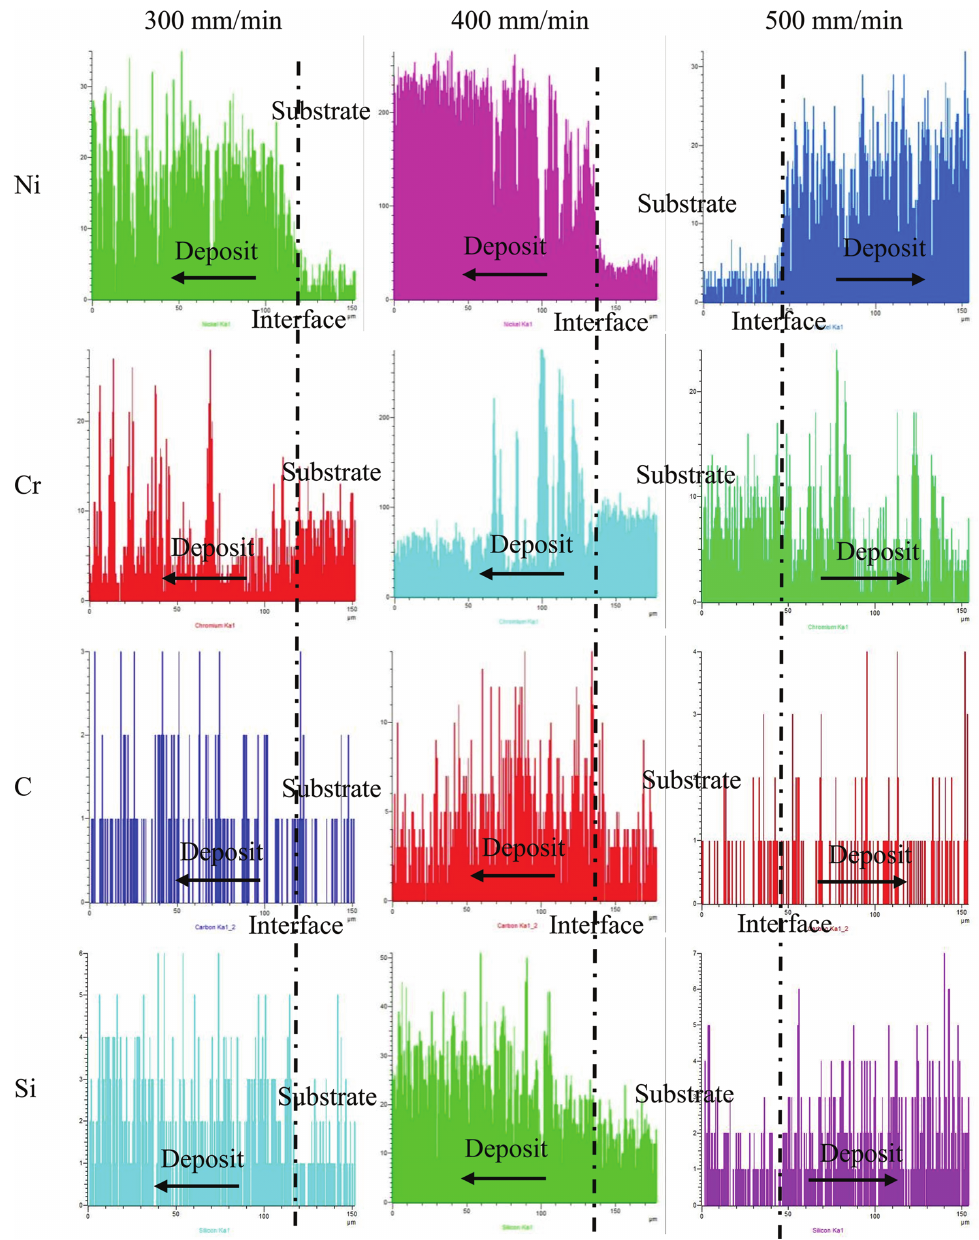
Figure 13: Effect of travel speed on Nickel (Ni), Chromium (Cr), Carbon (C) and Slicon (Si)